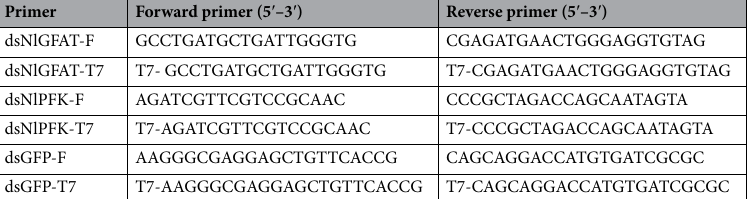
Table 2. Gene-specific primers used for double-stranded RNA synthesis. T7 sequence: 5 ′ -GGA TCC TAA TAC GAC TCA CTA TAG G-3 ′